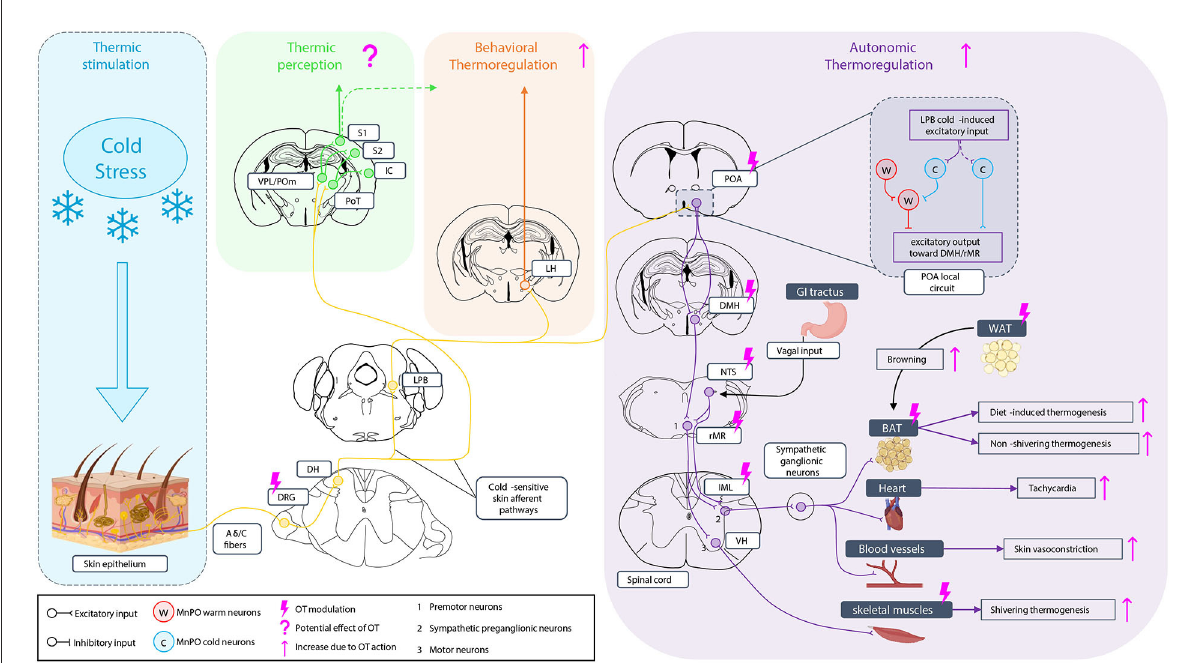
FIGURE1 Oxytocinergic modulation of the thermosensory system under cold stimulation. Under cold exposure, skin thermoreceptors expressed at dorsal root ganglia (DRG) neurons ending are activated and the sensitive information is conducted to medullar neurons of the dorsal horn (DH). The information is sent through two types of cold-sensitive skin afferent pathways: i) in one case, to the posteromedial (POm), the ventral posterior lateral nucleus (VPL), and the posterior triangular nucleus (PoT) of the thalamus. The PoT project to the insular cortex (IC), the VPL, and the PoT project to the accessory somatosensory cortex (S2), and the VPL and the POm project to the primary somatosensory cortex (S1) giving the perception of temperature; ii) in the second case, the cold-sensitive skin afferents contact the lateral parabrachial nucleus (LPB) where the information is once more separated in two pathways. The first goes to the lateral hypothalamus (LH) to engage the behavioral thermoregulation. A potential implication of the somatosensory cortex in behavioral thermoregulation is not excluded. The other one is related to autonomic thermoregulation. LPB projection goes to the preoptic area (POA), an integrating center of temperature information with a local circuit in which the inputs from the LPB excite excitatory cold-sensitive neurons but also lead to the activation of cold-sensitive neurons of the median preoptic nucleus (MnPO) that inhibit warm-sensitive neurons, leading to an excitatory output of the POA toward the dorsomedial hypothalamus (DMH). Neurons of the DMH then project to the rostral medullary raphe region (rMR) which is also contacted by neurons of the nucleus tractus solitarius (NTS) receiving visceral vagal input, for the induction of the diet-induced thermogenesis. Premotoneurons of the rMR project then to sympathetic preganglionic neurons of the IML, activating the sympathetic ganglionic neurons to induce the non-shivering thermogenesis of the brown adipose tissue (BAT), the diet-induced thermogenesis on the BAT (related to NTS input), heart tachycardia, and vasoconstriction of skin blood vessels. Premotoneurons of the rMR project also to motoneurons of the ventral horn (VH) of the medulla to induce skeletal muscle shivering thermogenesis. Oxytocin (OT) can modulate behavioral thermoregulation without knowing yet whether it can act on LH. It can modulate the autonomic thermoregulation at different levels increasing BAT and muscle thermogenesis, tachycardia, and vasoconstriction but also by stimulating white adipose tissue (WAT) browning toward BAT to increase the thermogenesis